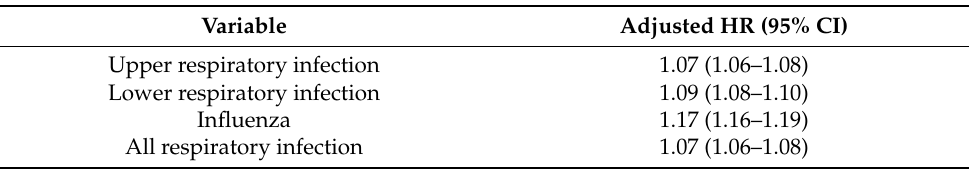
Table 2. Risks of respiratory infection in children with versus without attention-deficit/hyperactivity disorder.